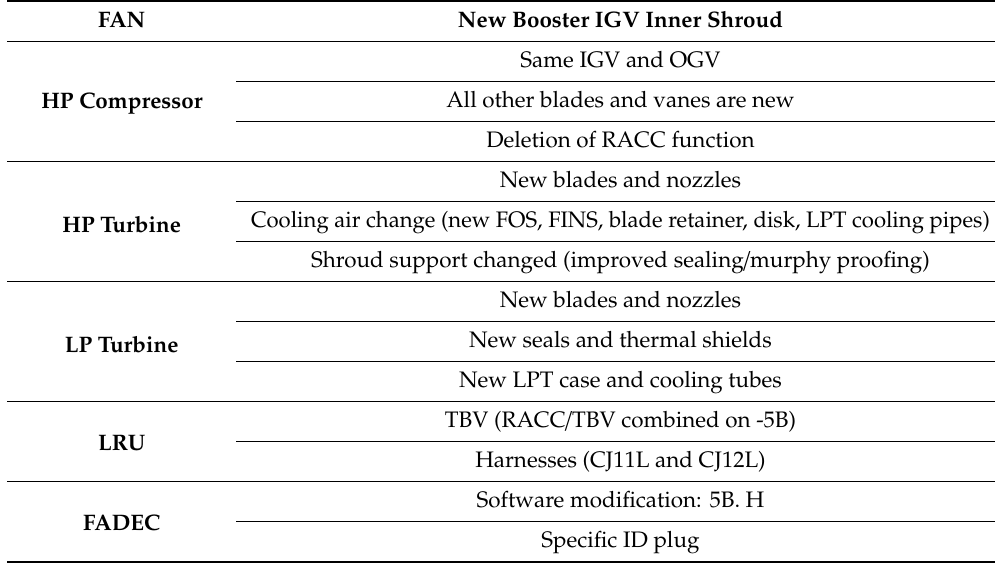
Table 1. CFM56-5B / P changes vs